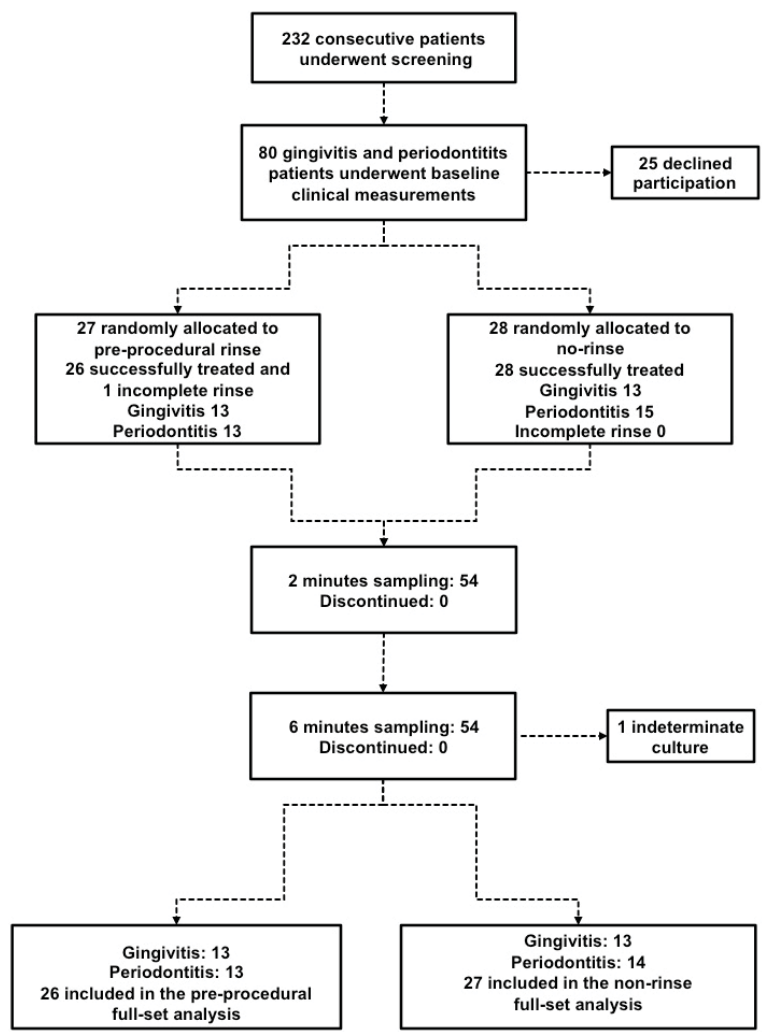
Figure 1- Study design from screening to completion of the 6-month